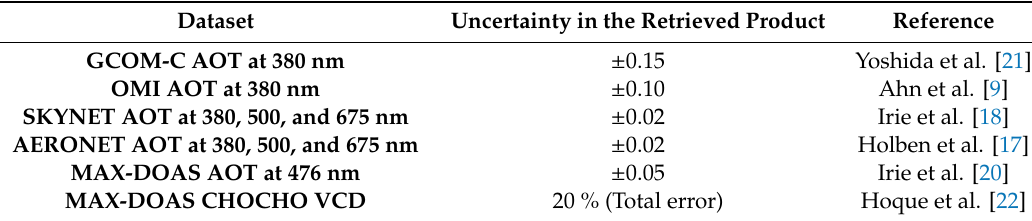
Table 1. The datasets used in the study and the uncertainties in the retrieved product.